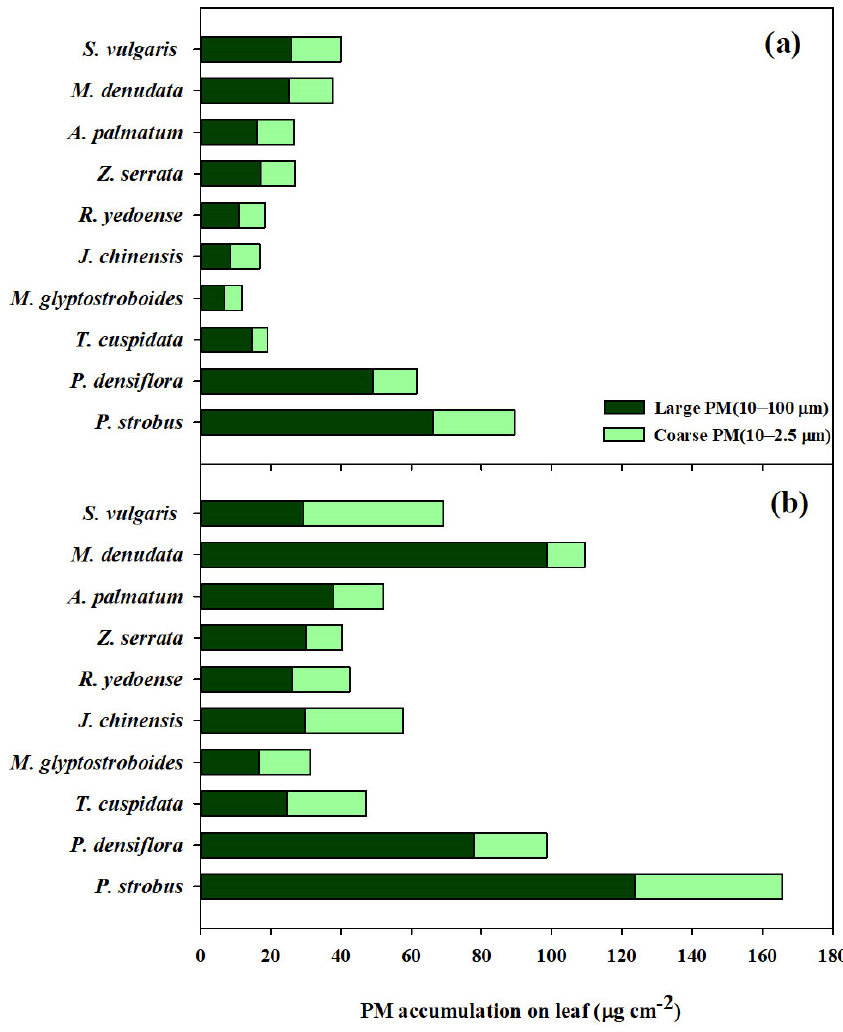
Figure 2. Particulate matter accumulation on leaves of 10 plant species in ( a ) urban forest and ( b ) roadside. When comparing the two sites, the amount of total PM accumulation on the leaf of the selected plants species along the roadside was higher than the amount of total PM accumulation of the same plant species at the urban forest (from 1.5 to 3.4 times). Plant species with the highest difference in the ratio of PM accumulation between the roadside and the urban forest were J. chinensis and M. denudata (about 3.4 and 2.9 times, respec ‐ tively). Among the 10 plant species, P. strobus , M. denudata , P. densiflora , and S. vulgaris had the highest PM accumulation while M. glyptostroboides had the lowest PM accumula ‐ tion. Additionally, the amount of wax on the leaves of the selected plant species differed with respect to the different sites and the different plant species. At both sites, we found